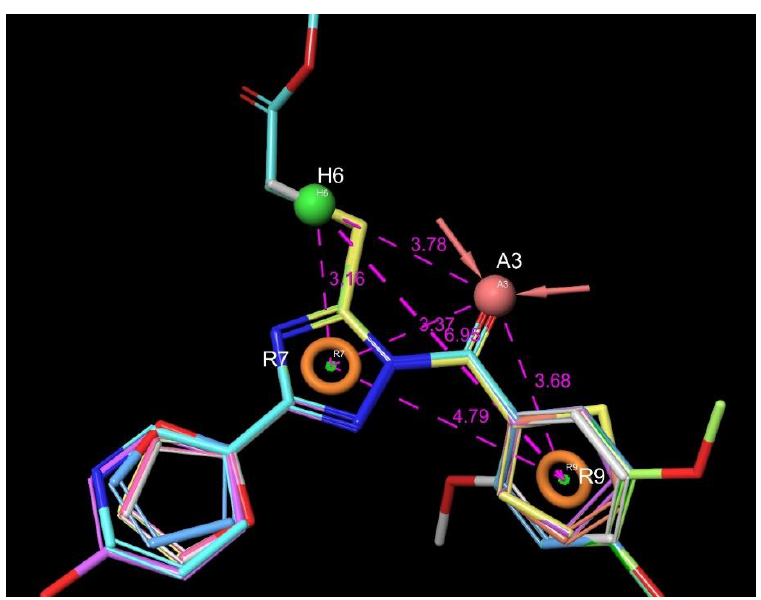
(R7) is slightly bent.